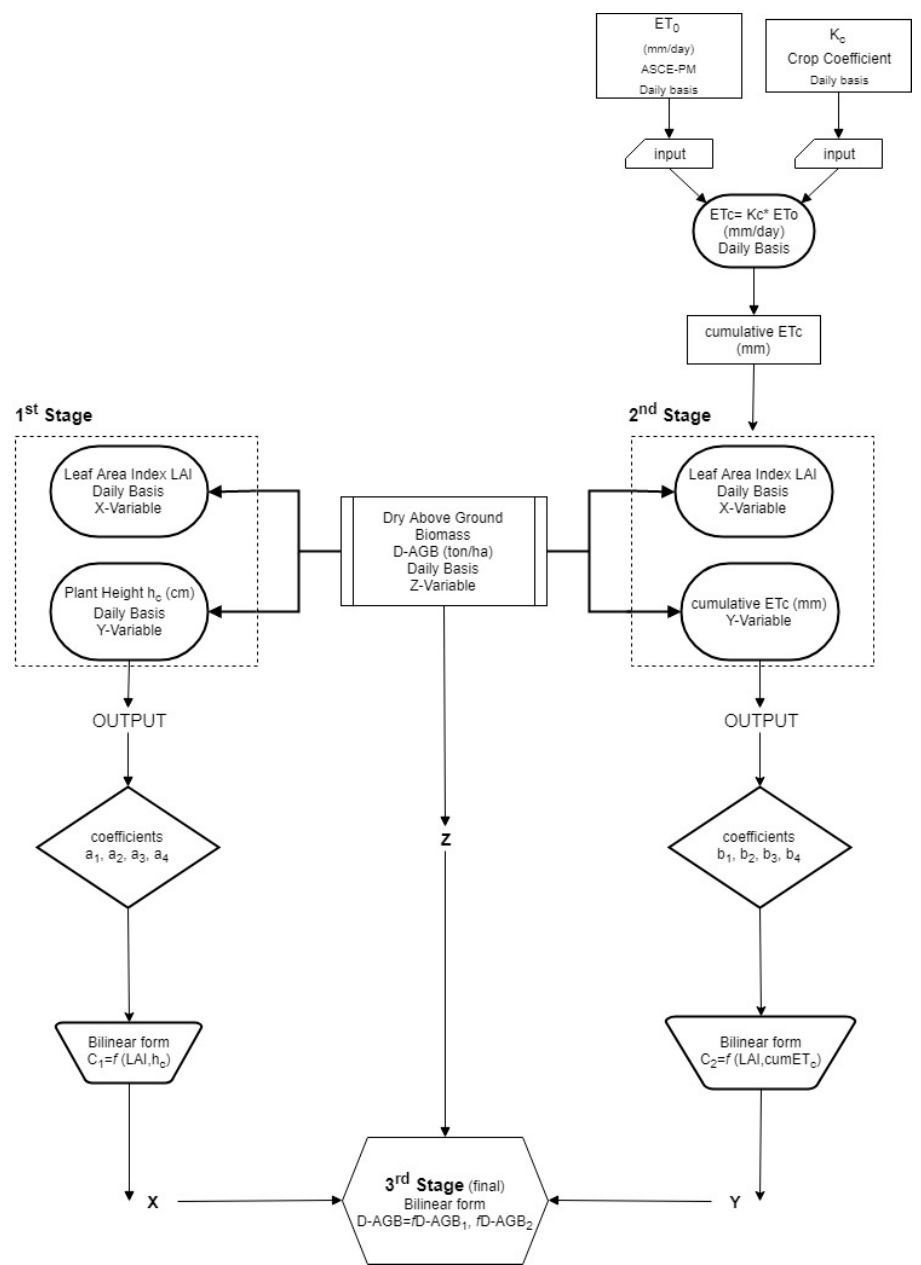
Figure 1. Flow chart showing the procedure of establishing the new empirical equation for daily estimation of dry above ground biomass ( D-AGB ).